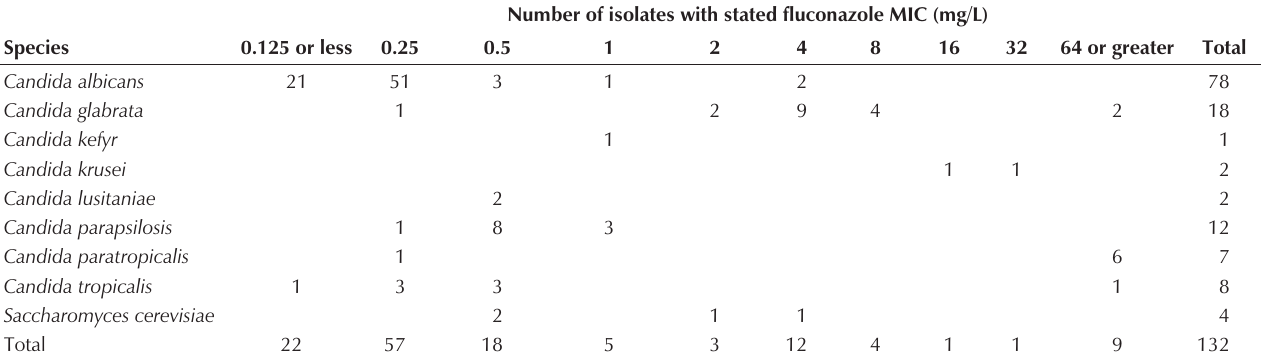
Distribution of fluconazole minimum inhibitory concentrations (MICs) by species for all years tested Number of isolates with stated fluconazole MIC (mg/L) Species